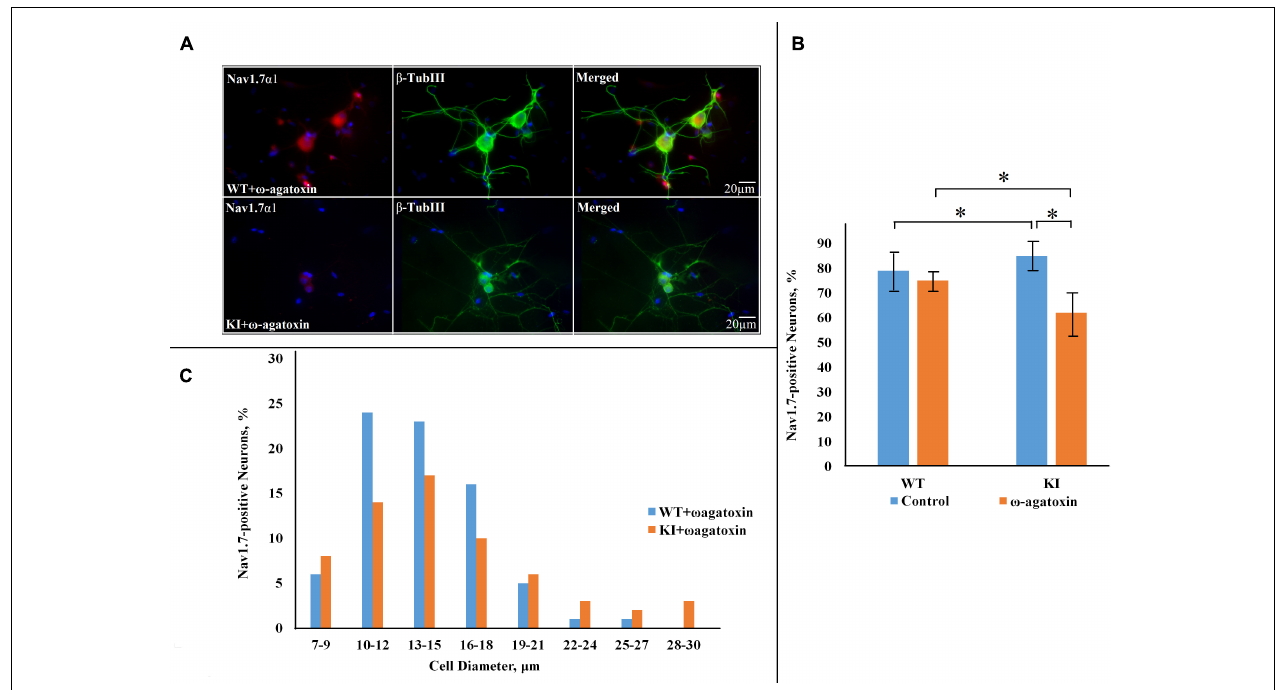
FIGURE 2 | Na V 1.7 α 1 subunit expression in WT and R192Q KI TG cultures after pretreatment with ω -agatoxin IVA. (A) Representative immunofluorescent examples of Na V 1.7 α 1 expression in WT and R192Q KI mouse TG cultures. ω -agatoxin IVA (200 nM, overnight: in this and subsequent Figures the toxin is abbreviated as ω -Agatoxin) was used to specifically block Ca V 2.1 channels (that are mutated in the KI model). Nuclei are visualized with DAPI (blue);